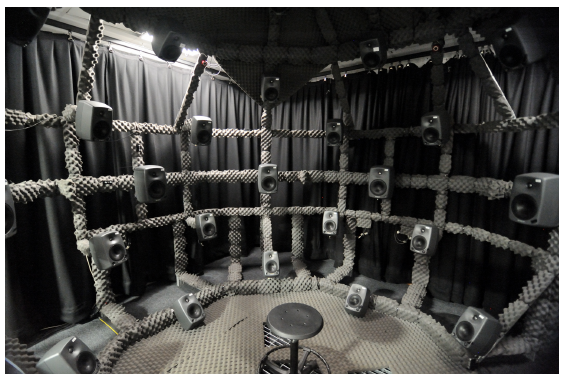
Figure 4. 50-channel spherical loudspeaker array at the AudioLab, University of York.